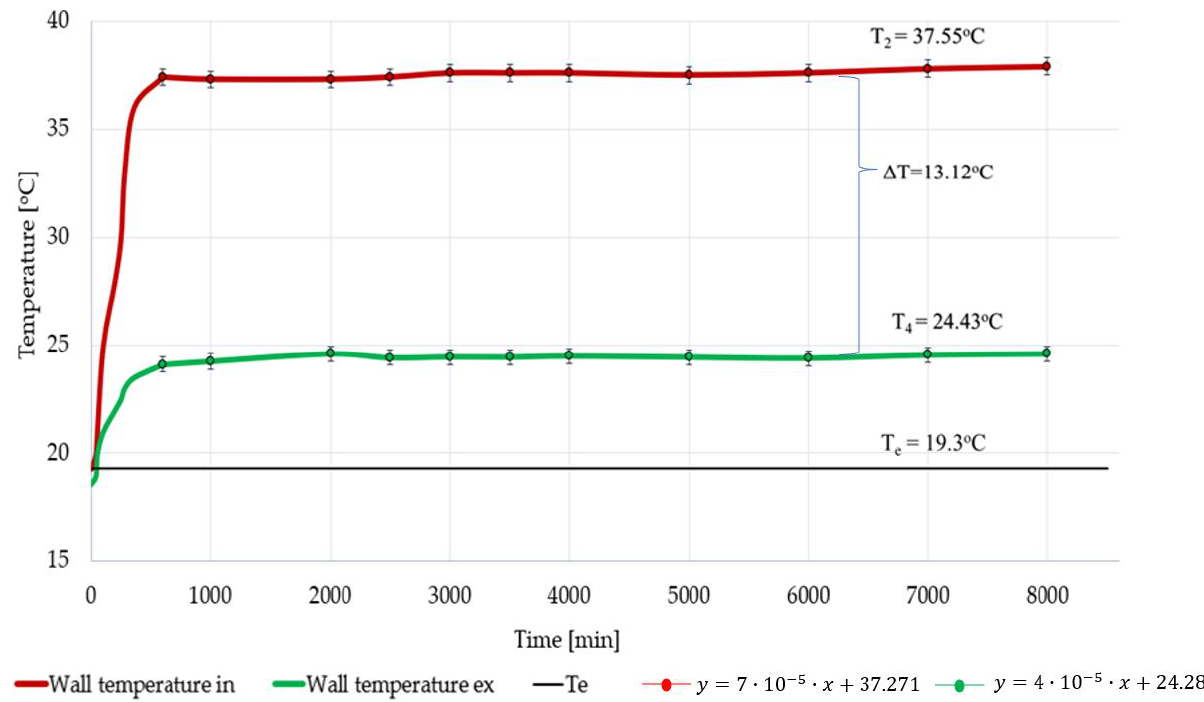
9 of 14 Figure 6. Measurement with a thermal camera of the temperature distribution on the outer walls of the measuring cube: ( a ) — side wall 1; ( b ) — side wall 2; ( c ) — side wall 3; ( d ) — side wall 4. Figure 7 shows the temperature profile on the side walls of the measuring cube on